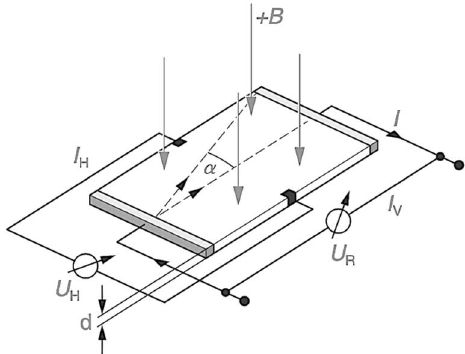
Figure 7. Illustration of the Hall effect principle, reproduced from [9]. Copyright 2007, Robert Bosch GmbH.